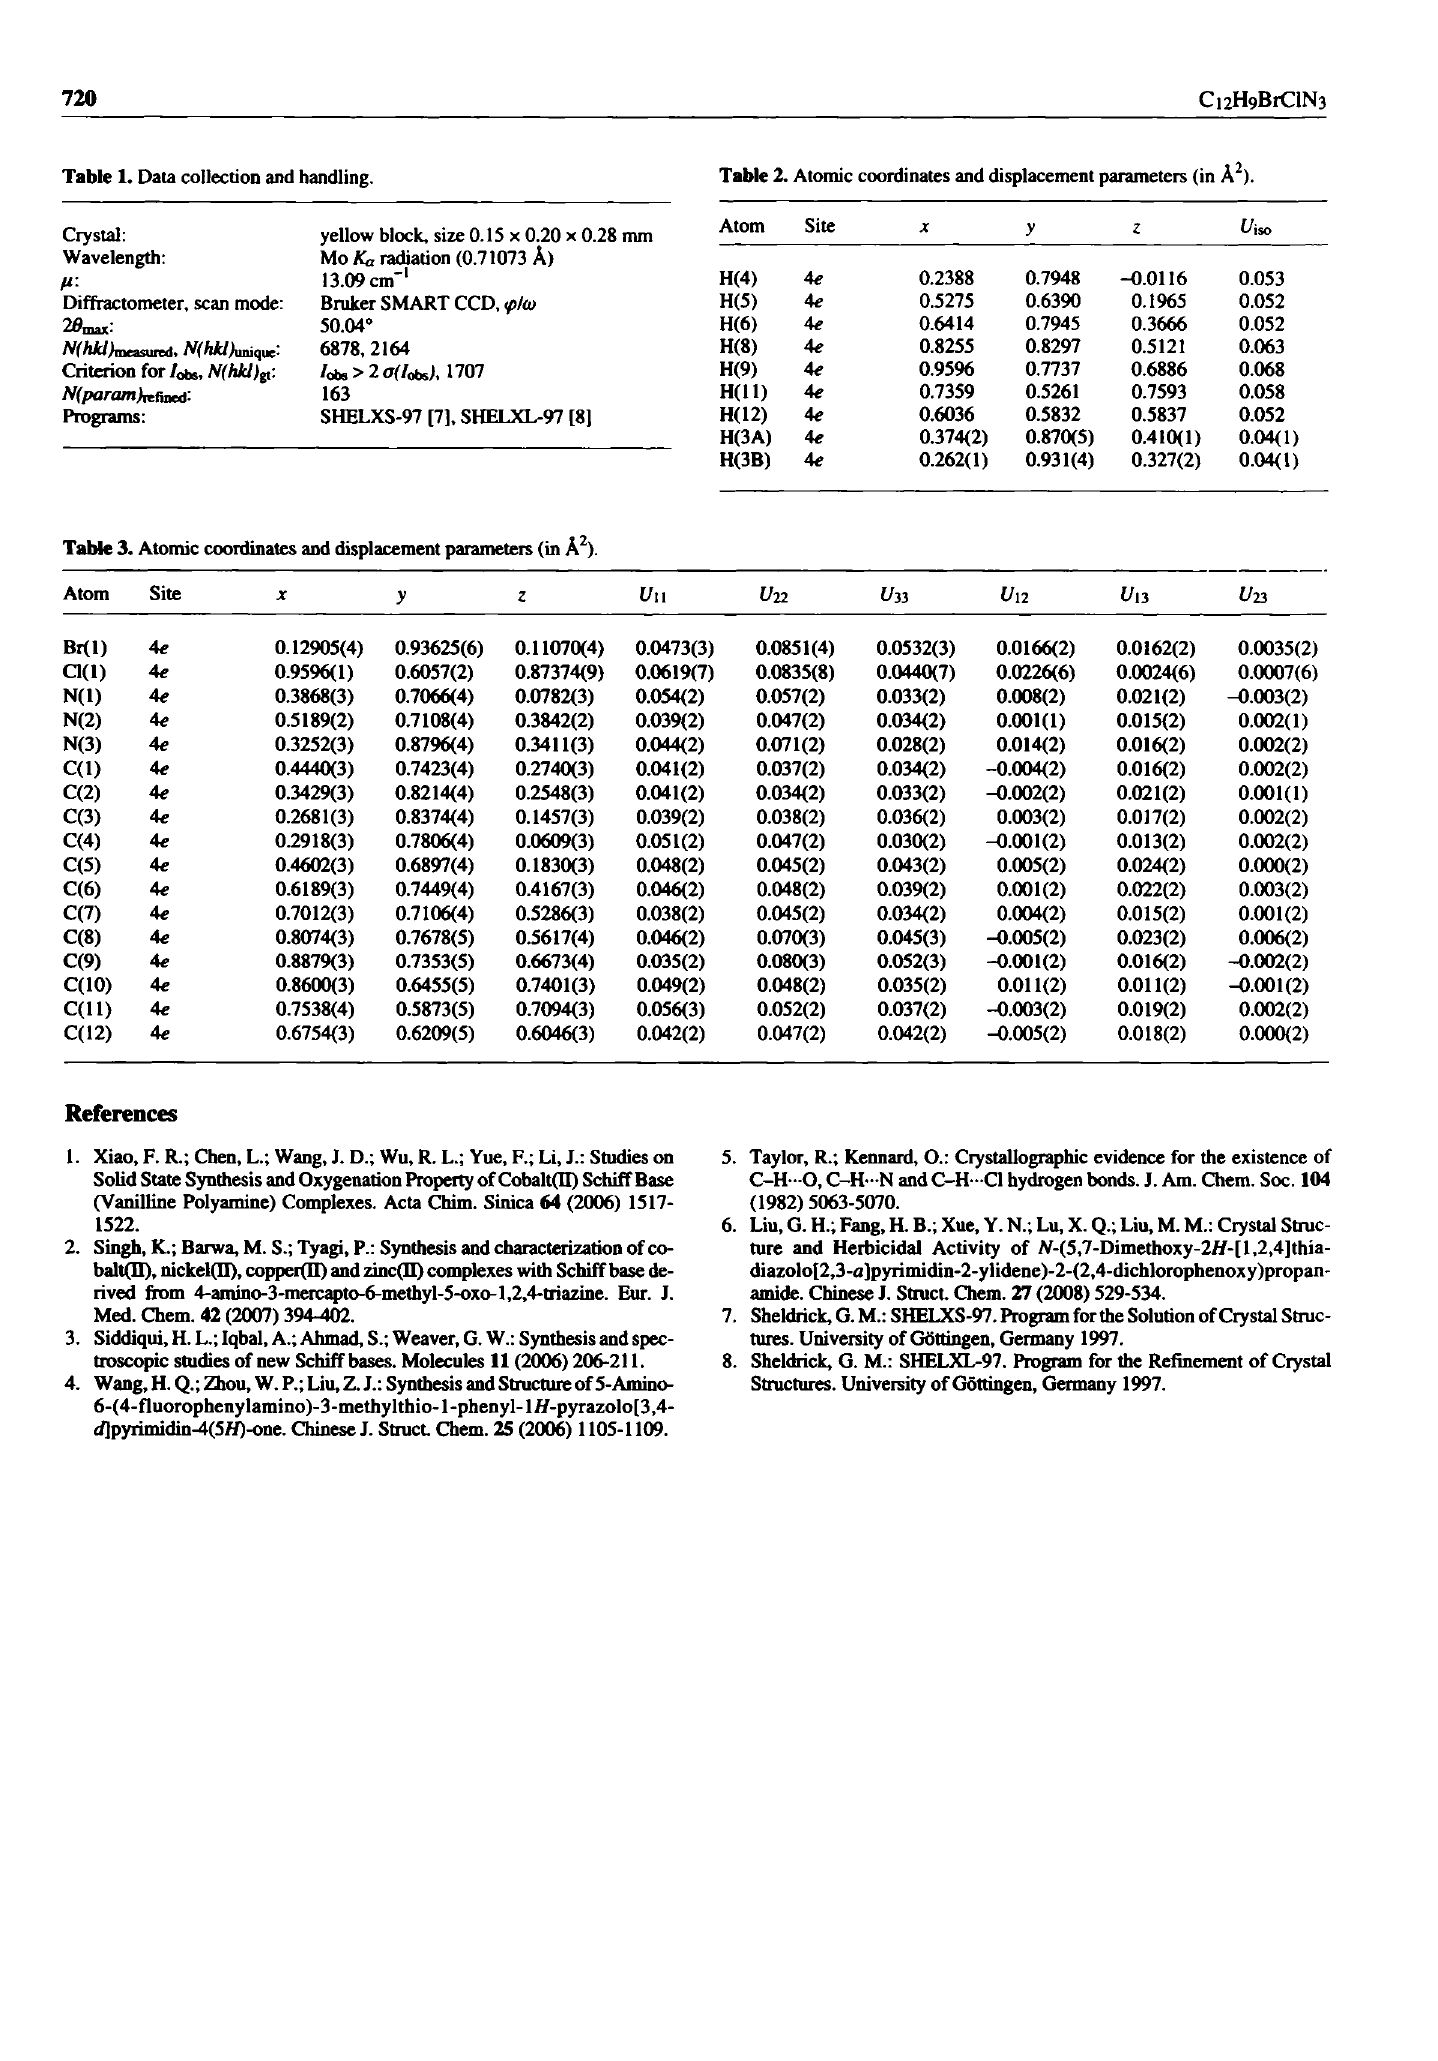
Table 1. Data collection and handling. Table 2. Atomic coordinates and displacement parameters (in Â 2 ).